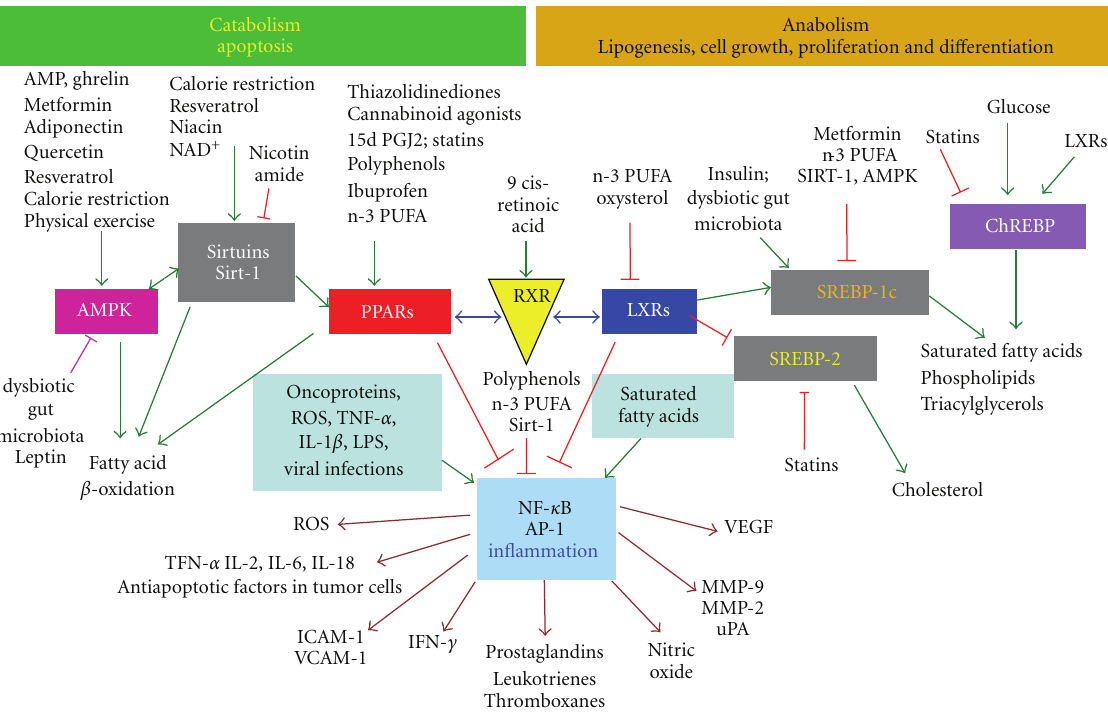
Figure 2: Schematic representation of biological responses to nutrients and cellular outcomes. Influence of some natural dietary compounds and some commondrugs on cell transcriptional activity in metabolism and inflammation.PPAR: peroxisome proliferator activated receptor; LXR: liver X receptor; RXR: retinoid X-receptor; NF- κ B: nuclear transcription factor- κ B; SREBP: steroid regulatory element-binding protein; ChREBP: carbohydrate responsive element-binding protein; Sirtuins: SIRT-1/2 deacetylating enzyme; AMPK: AMP Protein Kinase; MMP: metalloproteinase; VEGF: vascular endothelial growth factor; TNF: tumor necrosis factor; ROS: reactive oxygen species; ICAM - 1: intercellular adhesion molecule: VCAM - 1: vascular adhesion molecule; n-3 PUFA, omega-3 polyunsaturated fatty acids.